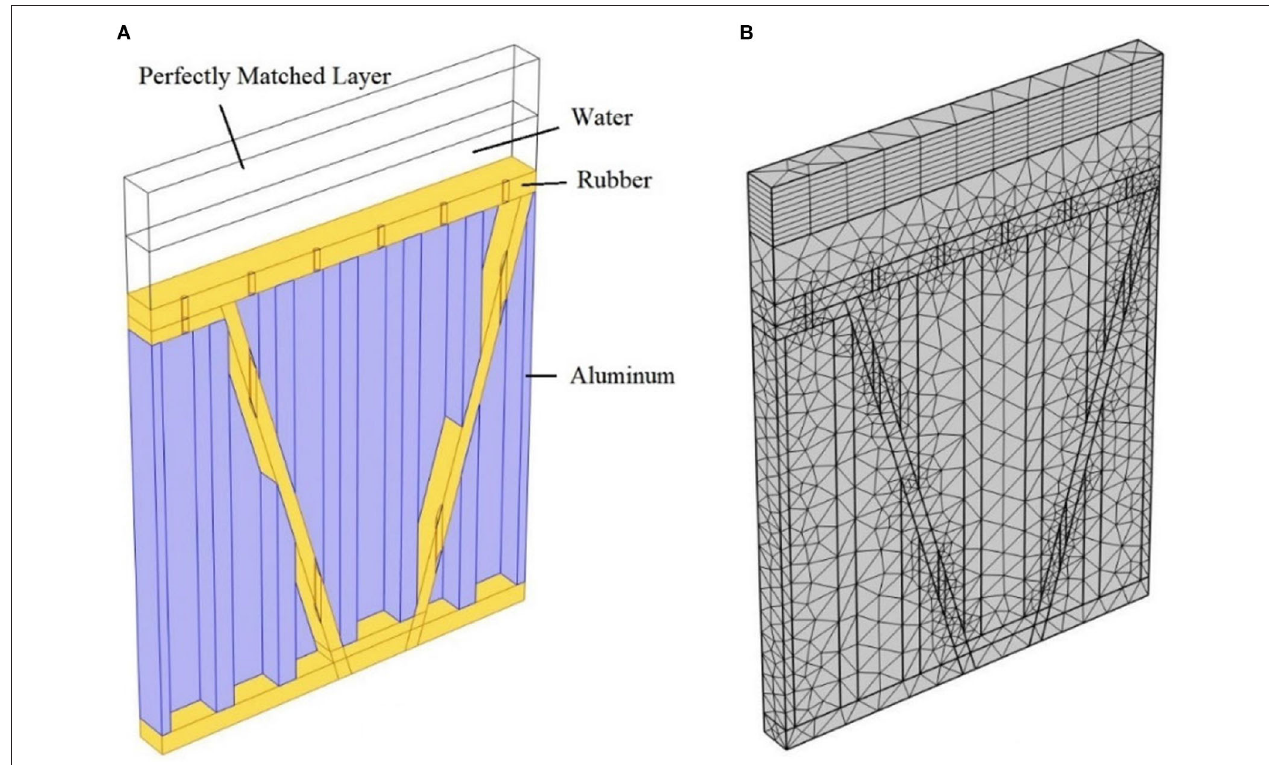
FIGURE 5 | COMSOL model for numerical simulation (A) Line frame of the model and materials settings; (B) Mesh built of the model.